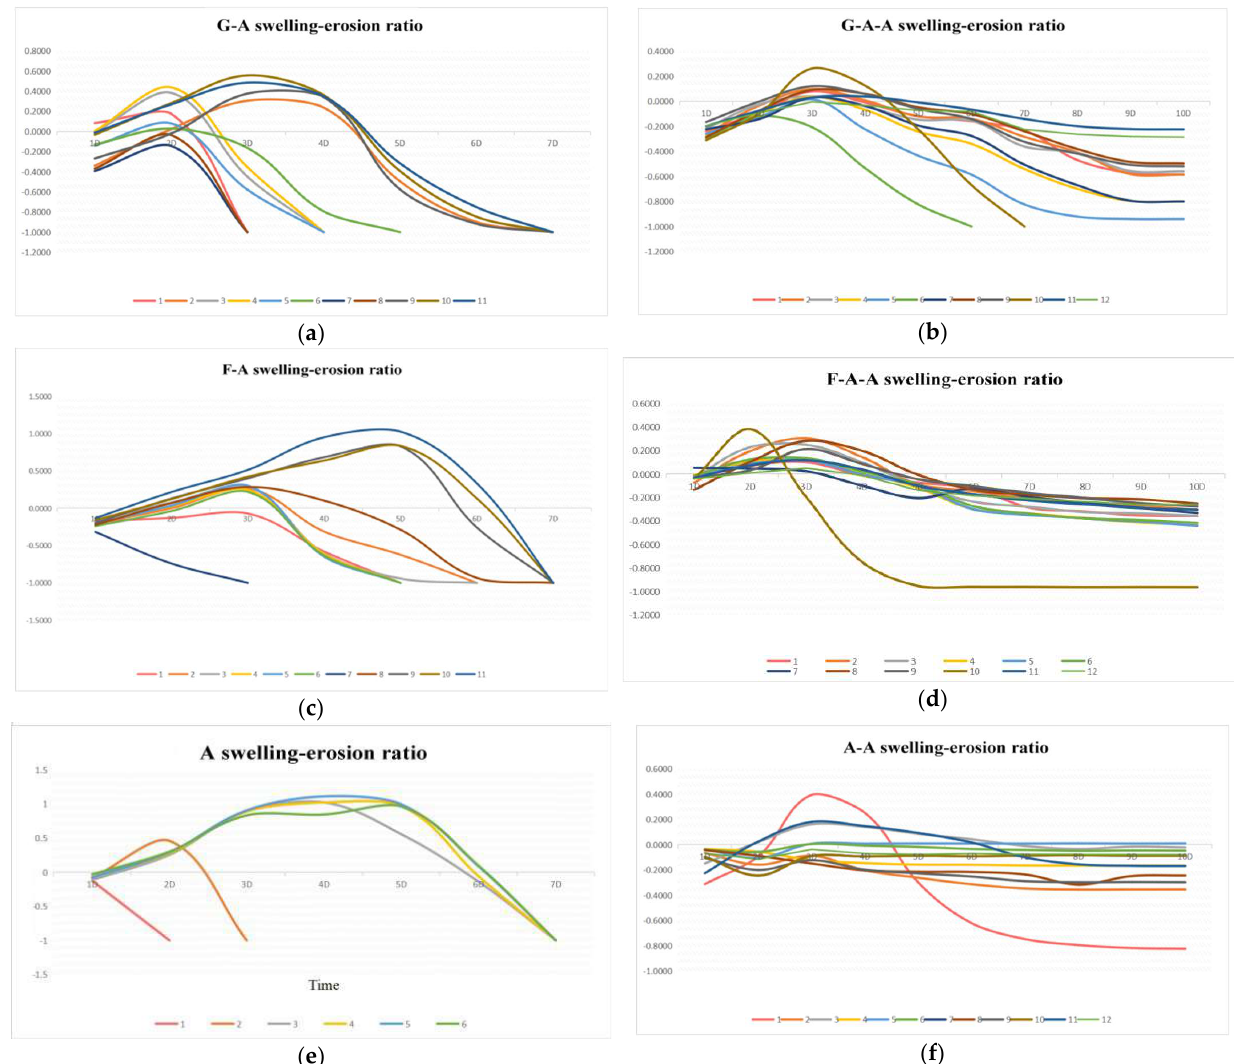
Figure 5. Swelling-erosion ratio of the alginate-based hydrogels: ( a ) G-A hydrogel; ( b ) G-A-A hydrogels; ( c ) F-A hydrogels; ( d ) F-A-A hydrogels; ( e ) A hydrogels; ( f ) A-A hydrogels.